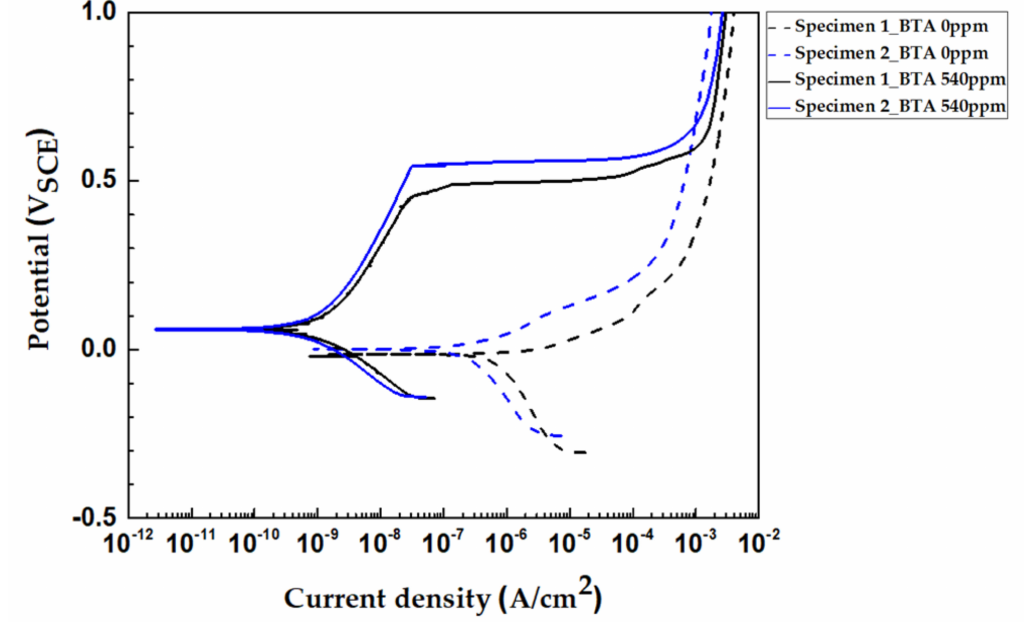
Figure 5. Potentiodynamic polarization curves for specimen 1 and specimen 2 in synthetic tap water at 25 ◦ C according to the presence and absence of BTA.